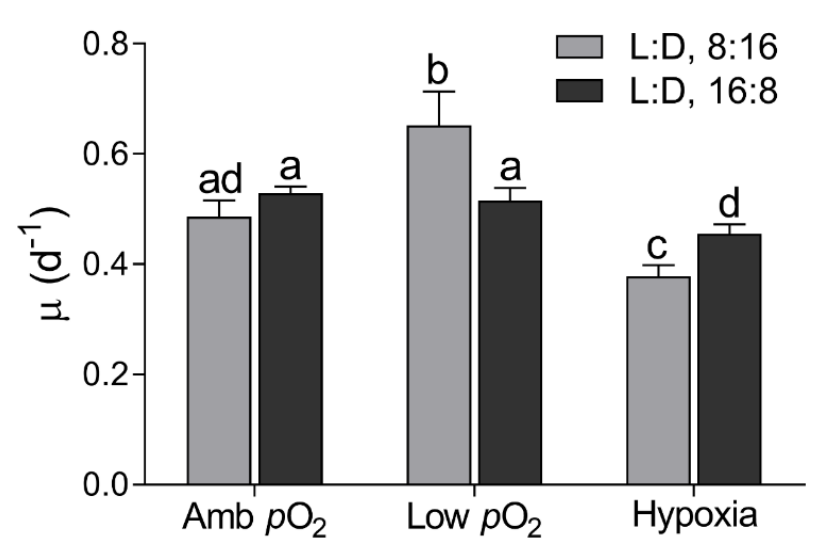
Figure 1. Specific growth rate ( µ , day − 1 ) of T. pseudonana under 8:16 and 16:8 Light:Dark (L:D) cycles, under ambient p O 2 (Amb p O 2 ), low p O 2 (Low p O 2 ), and hypoxia (Hypoxia) conditions. The vertical bar shows the standard deviation ( n = 3), and different letters on top of the bar indicate the significant differences ( p < 0.05, one-way